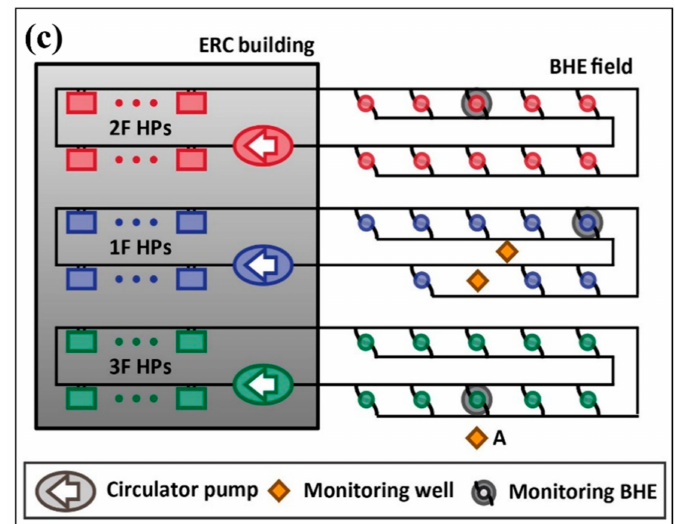
Figure 1. Location of the study area ( a ), a satellite view of the Earthquake Research Center (ERC) building and borehole heat exchanger (BHE) field ( b ) and the layout of the geothermal heat pump (GHP) system in the ERC building ( c ). The vertical closed-loop GHP system comprises 79 heat pumps, 4 fluid pumps, and 28 BHEs. The dimensions of the BHE field are 35 m from east to west and 42 m from north to south. Red, blue, and green boxes in the ERC building represent heat pumps for each